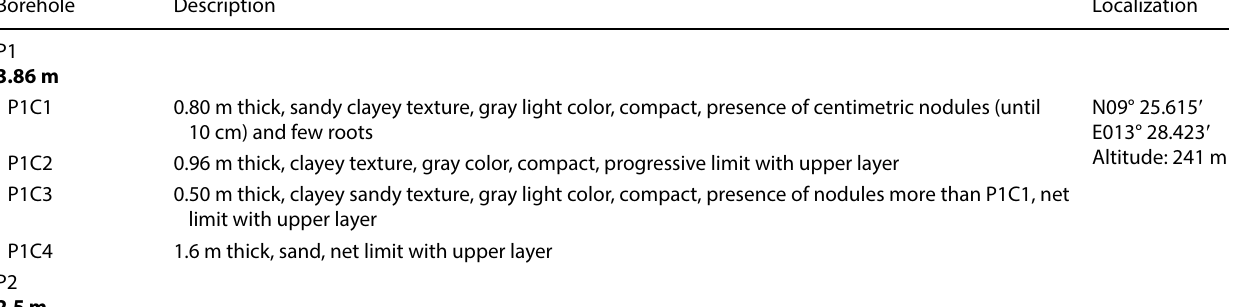
Table 1 Macroscopic description of profiles Borehole Description